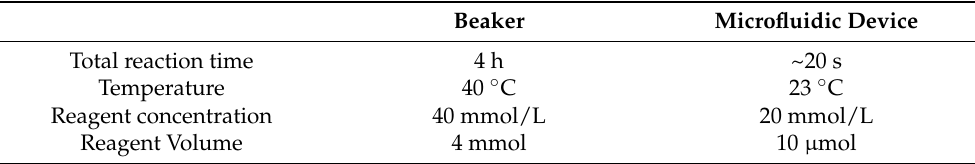
Table 2. Comparison of reaction conditions between beakers and the microfluidic device.